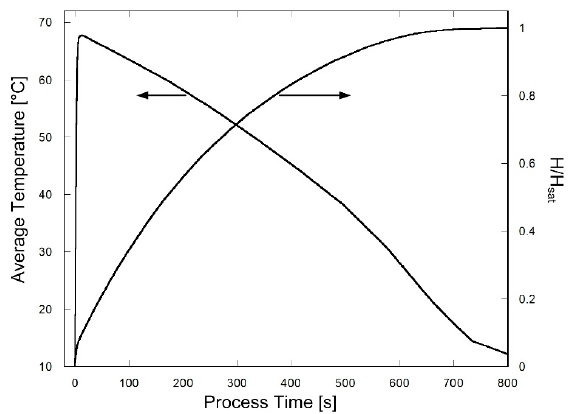
Figure 2. The volume ‐ average temperature of metal hydride and hydrogen absorption over the process time. process